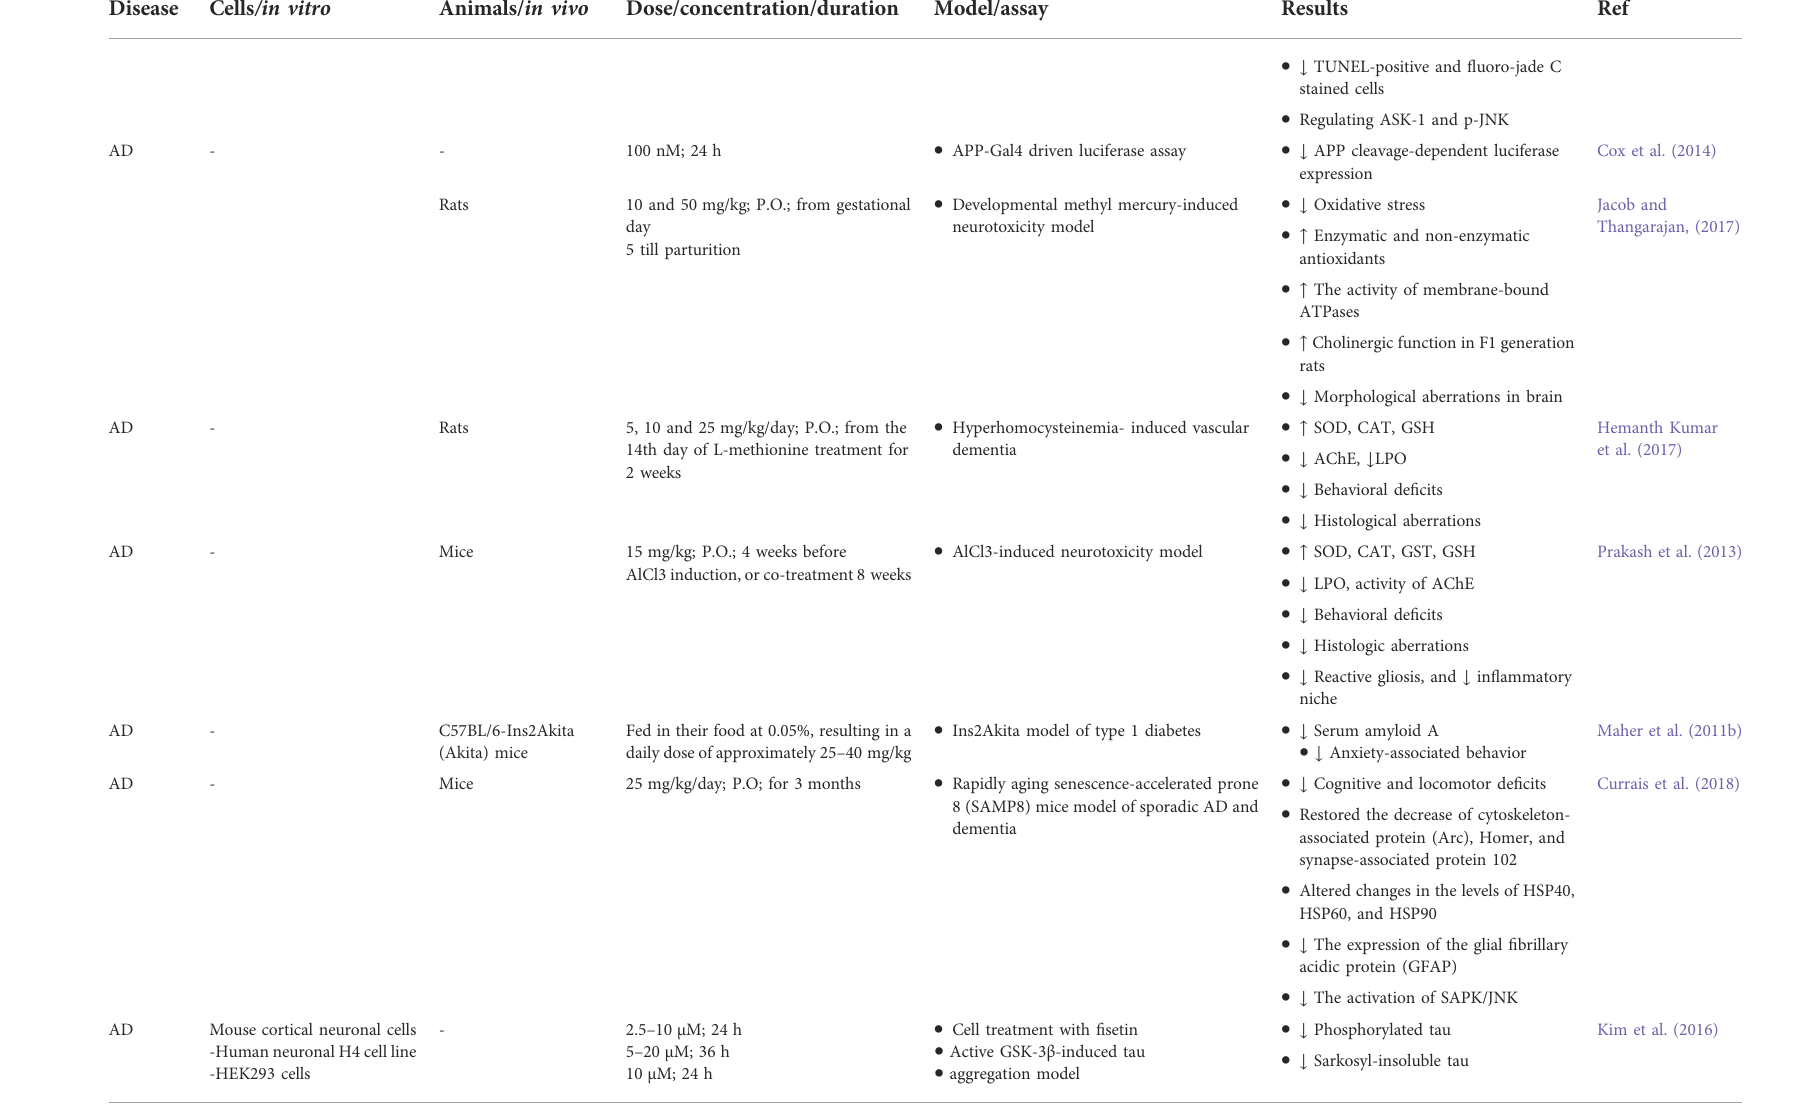
TABLE 1 ( Continued ) Different neurodegenerative disease and the protective role of fi